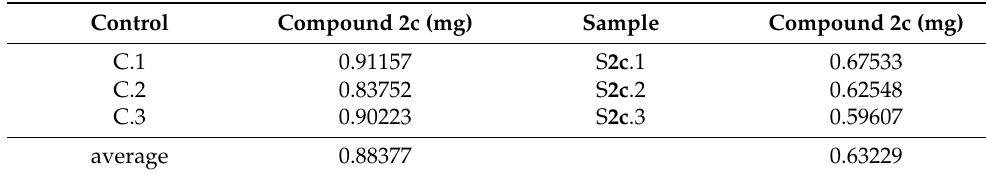
Table 1. HPLC analysis of compound 2c in the medium.